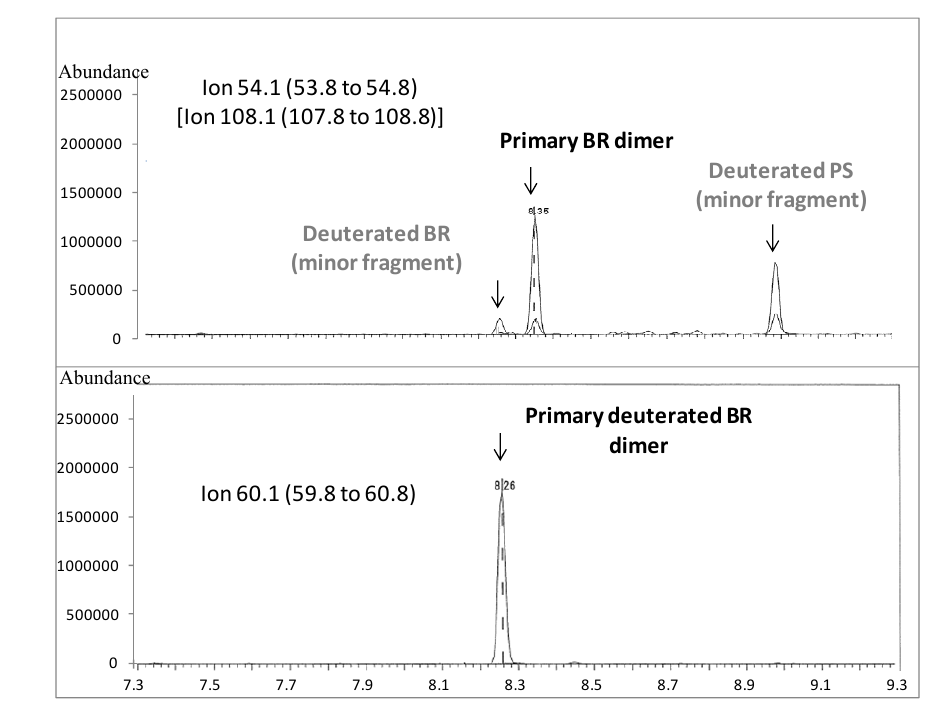
Figure 2. Typical pyrograms generated during calibration curve preparation with identified source. The primary BR and IR dimers are vinylcyclohexene and dipentene, respectively. ( a ) 100 µg SBR with 75 µg deuterated BR; ( b ) 10 µg IR with 10 µg deuterated